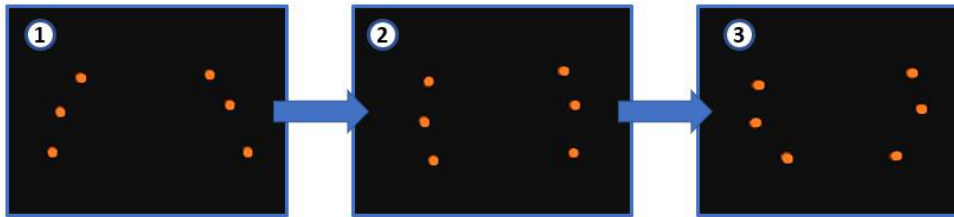
Figure 14. Closing sequence on the pipe and the limbs’ deformation.In the first picture, the tentacles are open. In the second, they begin to close. Finally, in the third picture, the limbs are completely close, adapting to the shape of the pipe.